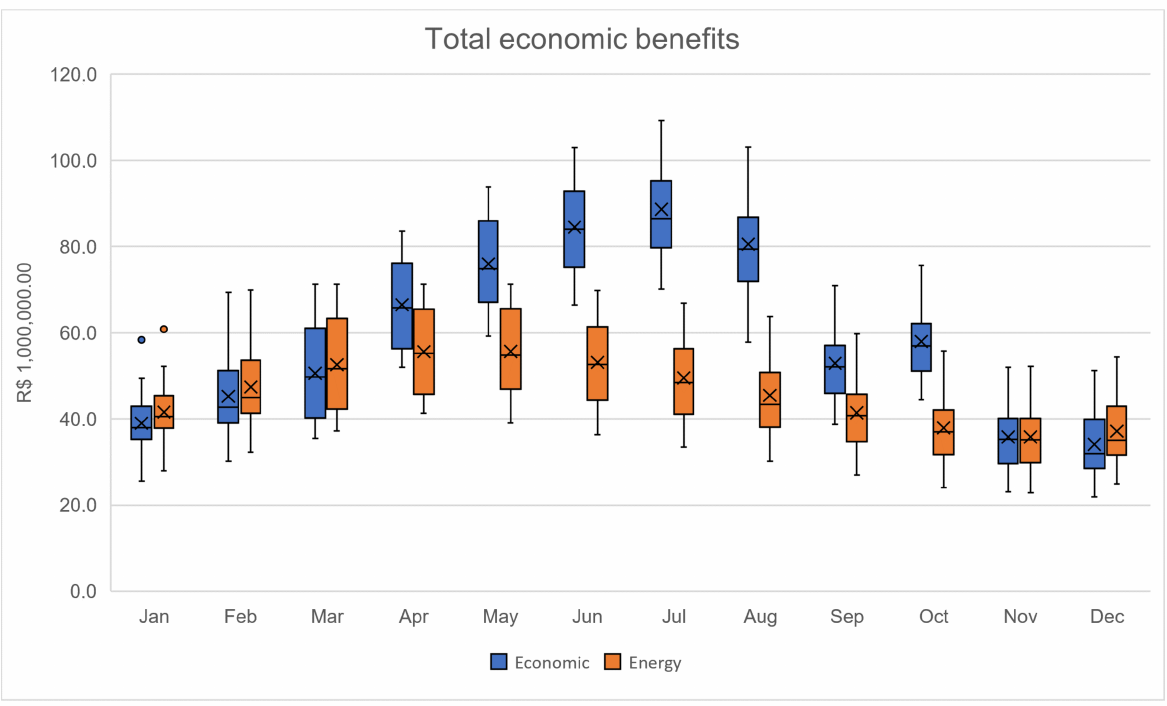
Figure 11. Monthly economic benefits in the